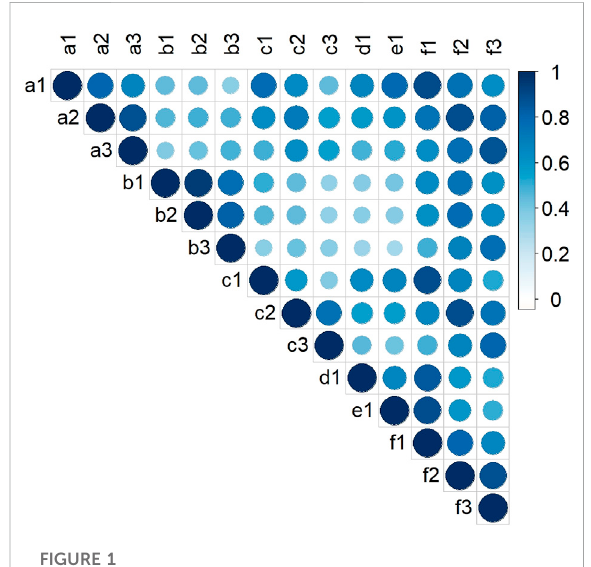
FIGURE 1 Pearson correlation coef fi cients for LA-related traits of maize in the association mapping panel in different environments. (a ‒ f) : HB,YC,YY,YYC, YYX,andBLUP, respectively; (1 – 3): ULA,MLA, and LLA,